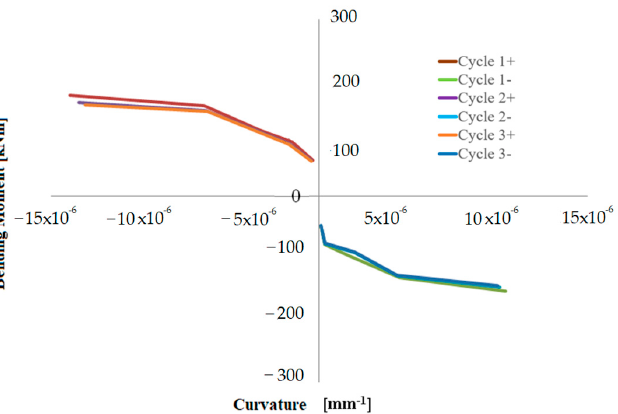
Figure 15. Bending moment-curvature diagram at the height of 0.06 m from the base—rectangular pier.